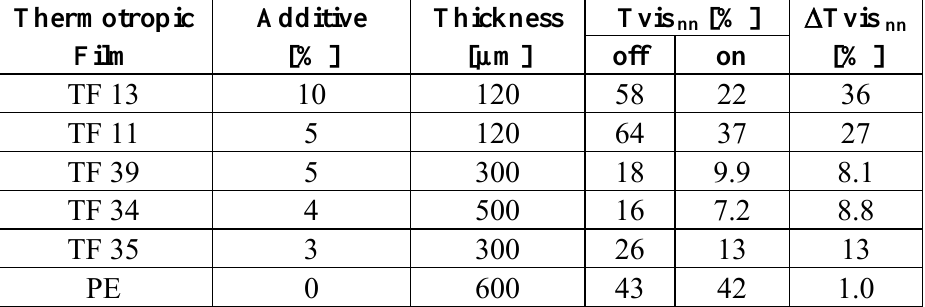
Table 2. PE films with thermotropic additives.